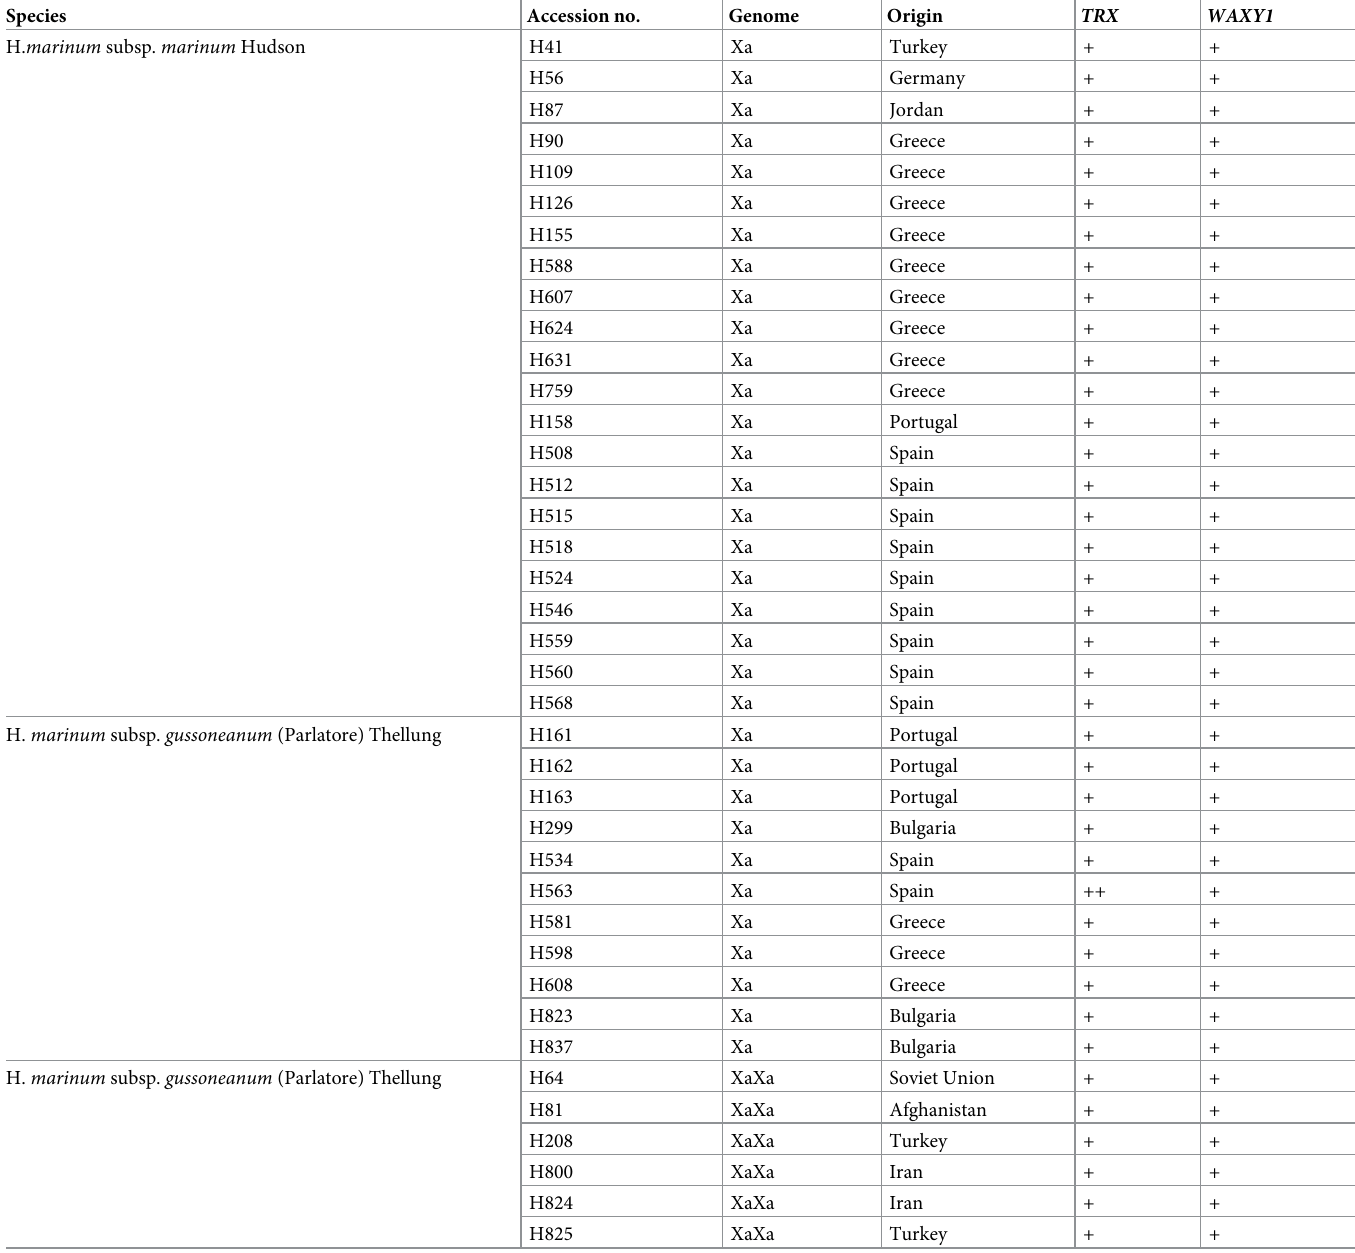
Table 1. The species, accession number, genome and origin of 39 sea barley used in this study. Species Accession